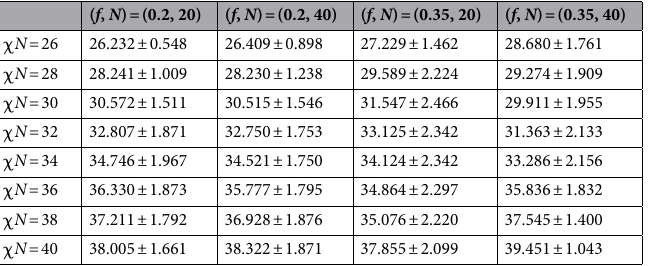
Table 6. Averages and standard deviations of estimated χ N for each χ N class for the binarized images. Here, the χ N class was same value of the teaching image.